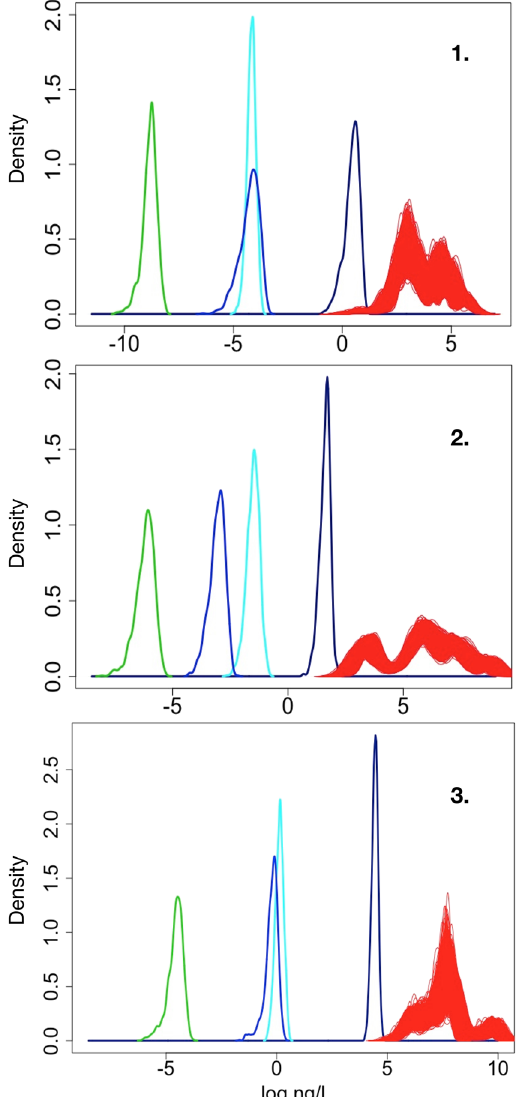
Figure 6. Water risk evaluations (1) for Ag-, (2) CeO 2 -, and (3) SiO 2 -ENMs by comparing PECs (most probable range) of 2050 and 1,000 PSSD curves (in red). The PEC curves (form left to right) represent marine water (green) loaded only from releases associated with end of life (EOL) of ENMs, in blue marine water loaded from ENM product uses, and EOL releases followed by the equivalent freshwater loadings from EOL (light blue) and total (use and EOL) release (dark